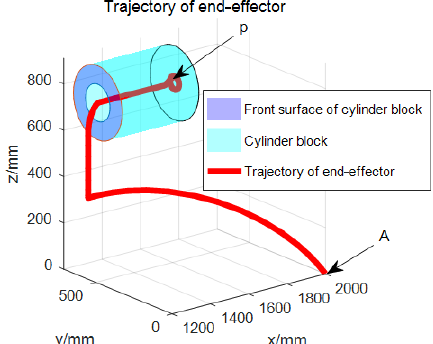
Figure 5. The trajectory of the